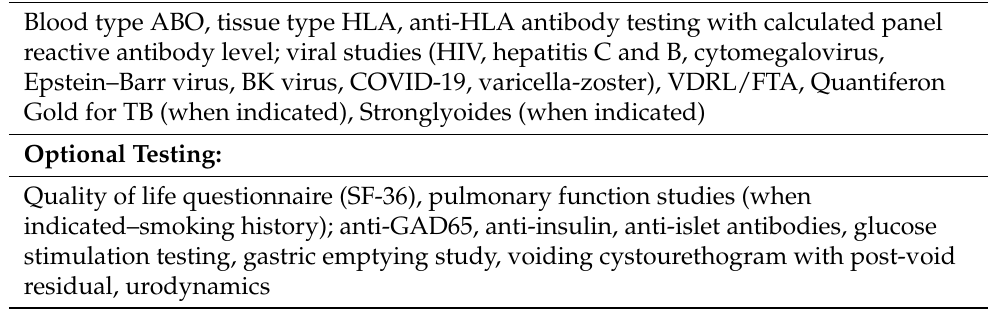
Table 2. Cont. Infectious Disease, Immunologic, and Serologic Testing: Blood type ABO, tissue type HLA, anti-HLA antibody testing with calculated